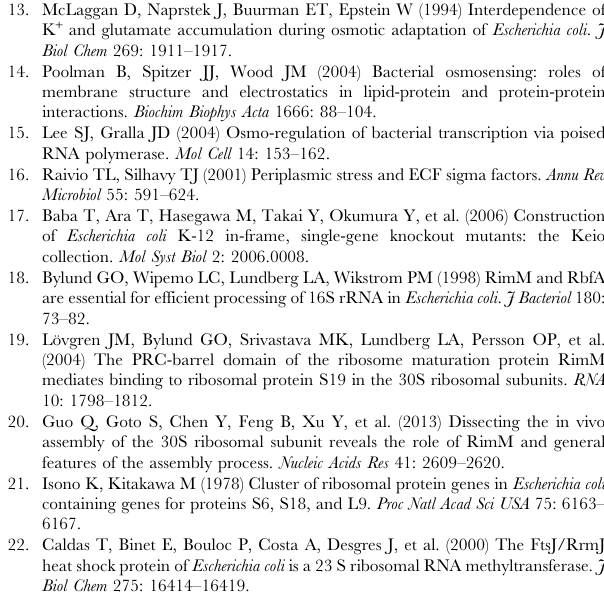
One m g of total RNA fraction prepared from each of the cells was electrophoresed on 1.8% agarose gel. The 3 9 truncation product of 16S rRNA is indicated by an asterisk. Table S1 Concentrations of drugs used in this study. Three different concentrations for each antibiotic, which were determined in consideration of the inhibitory effect on the growth of wild type cells in LB medium in the absence of salt shock, were used. The lowest of the three concentrations had almost no effect on growth rate. The highest concentration was determined so that it inhibited the growth rate of wild type cells in the absence of salt stress to the level similar to that of D rsgA cells. Some antibiotics such as kanamycin and streptomycin drastically decreased the plateau level of growth curve, and in this case the highest concentration was adjusted so that OD 600 at the plateau was nearly equal to or slightly lower than 1.0. At each time point, OD 600 was measured and compared with that of wild type cells grown without antibiotics.